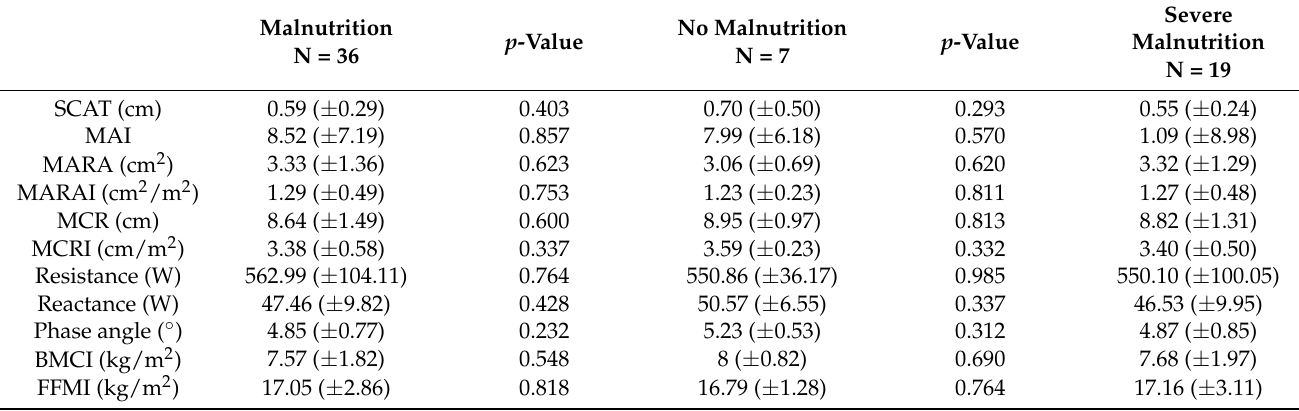
Table 3. Differences between the morphofunctional assessment parameters (ultrasonography and bioimpedanciometry) based on the diagnosis of malnutrition and severe malnutrition using GLIM